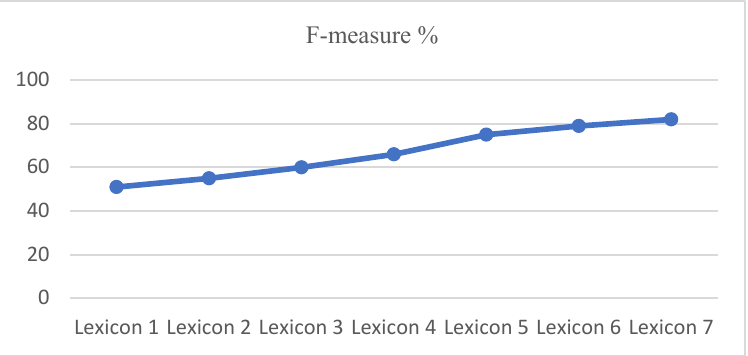
Figure 2. Illustration of the size and performance of each sentiment lexicon.